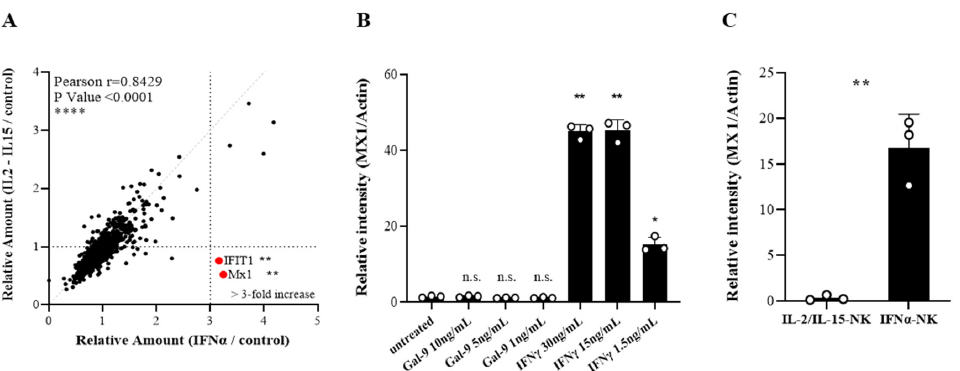
Figure 7. ( A ) Correlation between secretome data of HCV-Huh7.5 cells co-cultured with IFN α -NKs (x-axis) or IL2/IL15-NKs (y-axis). Relative expression levels, as determined with MS-based quantitative proteomics, are plotted for 2038 of proteins. Linear regression and Pearson’s r are indicated. The vertical line reflects a fold change ≥ 3.0 in IFN α -NKs with respect to IL2/IL15-NKs. The annotated red dots represent two proteins that were dysregulated in opposite directions. ( B , C ) Relative optical density of MX1 protein bands from Western blot films loaded with total protein extracts from HCV-Huh7.5 cells treated with decreasing doses of galectin-9 (1–10 ng/mL) or IFN- γ (1.5–30 ng/mL) ( B ) or stimulated with either IL2/IL15-NK or IFN α -NKs ( C ). Each dot represents a technical replicate. Mean values ± SD are shown. Statistical analyses were performed with the one-way ANOVA with the Holm–Šídák multiple comparisons test ( B ) or Student’s t-test ( C ). * p < 0.05, ** p < 0.01; n.s., non-significant.